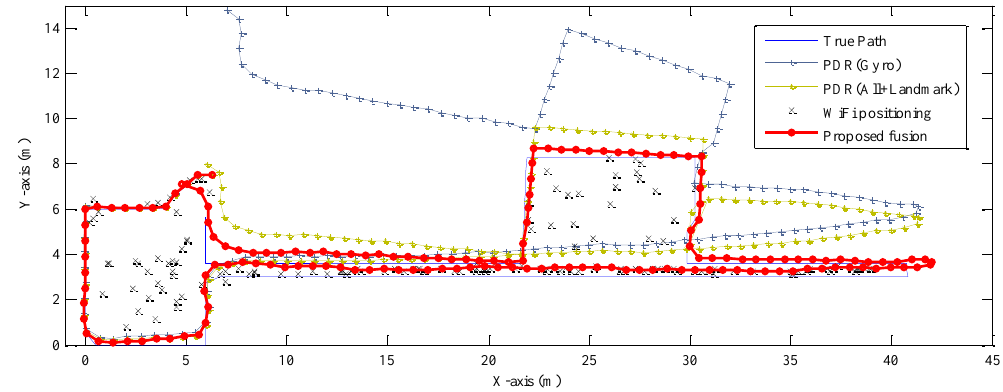
Figure 7. Comparisons between the true path one, trajectories of the proposed fusion approach, PDR (Gyro), PDR (All+Landmark), and WiFi positioning.